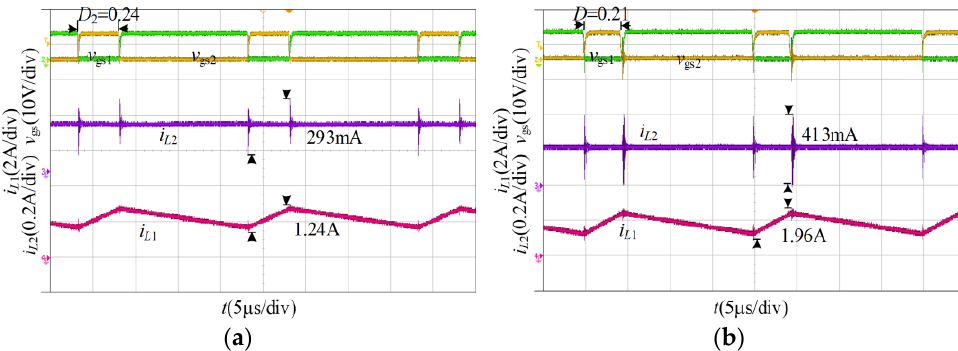
Figure 18. The stable experimental waveforms of i L 1 , i L 2 in step-down mode: ( a ) V 1 = 400 V; ( b ) V 1 = 450 V.